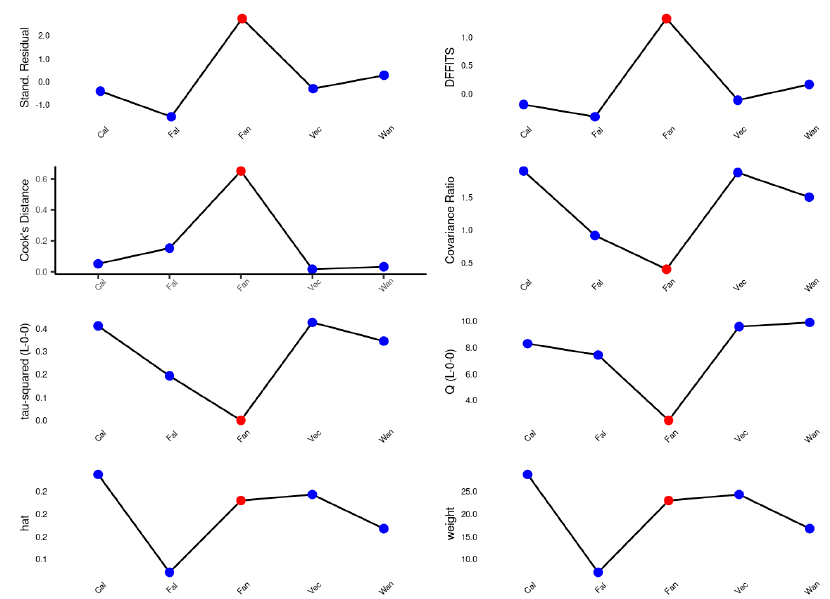
Figure A2. Influence graph. Stand. Residual: standardized residuals for each study; DFFITS: differ- ence in fit(s) of studentized residuals for each study; Cook´s distance: residuals removing each time from one study; Covariance ratio: ratio between variance pooled effect and initial average effect; tau-squared (L-O-O): tau squared leave-one-out plot is the heterogeneity measure by tau squared removing a single study each time; Q (L-O-O): Cochrane test leave-one-out plot is the heterogeneity measure Cochran Q test removing a single study each time; hat: model predictions for each study; weight: studies’ weight. Red points are influencing studies, blue points are not influencing studies.